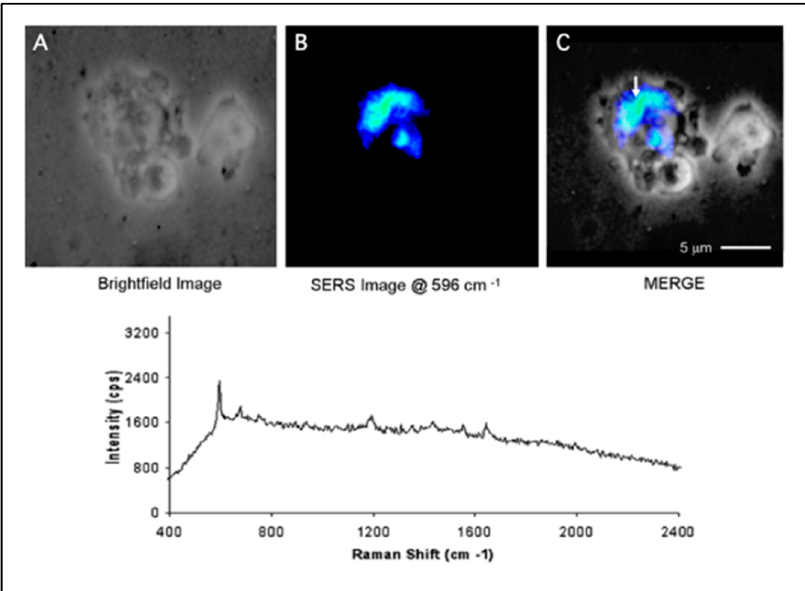
Figure 3. SERS images and spectra of CHO cells incubated with cresyl violet-labeled silver colloidal particles. The bright field image ( A ), the total SERS image ( B ), and the merged image ( C ) of a fixed cell are shown. The arrow indicates regions within the cell where clusters of silver nanostructures are located. The SERS image was acquired at a SERS intensity signal of 596 cm − 1 using a 632.8 nm HeNe laser for excitation. Scale bars are of 5 µm. Adapted from [39].